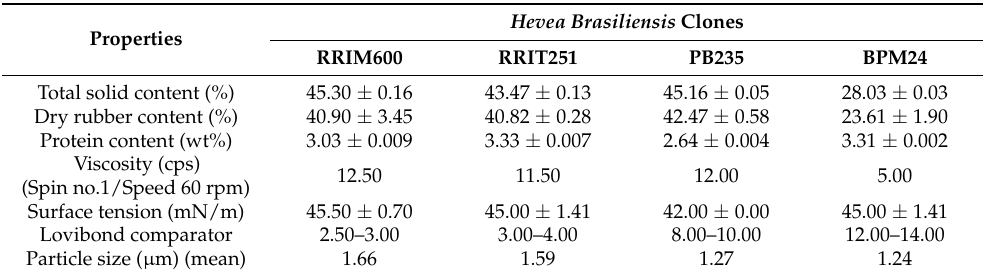
Table 3. TSC, DRC, protein content, surface tension, viscosity, lovibond comparator and particle size of the fresh natural latex from four different Hevea brasiliensis clones.